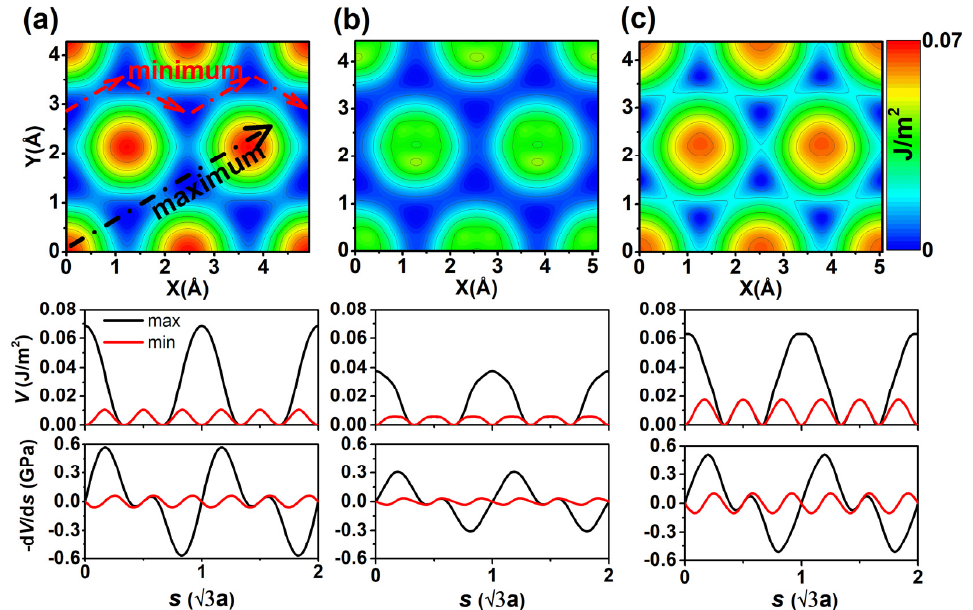
Figure 4. Potential energy surfaces (PES). ( a ) H-diam/H-diam, ( b ) F-diam/F-diam, and ( c ) graphene- graphene systems. The corresponding potential barrier V and lateral stress τ = − d V /d s as functions of sliding distance s (in unit of √ 3 times of lattice constant) along the minimum and maximum barrier paths are plotted under each PES. The minimum is taken as a reference.